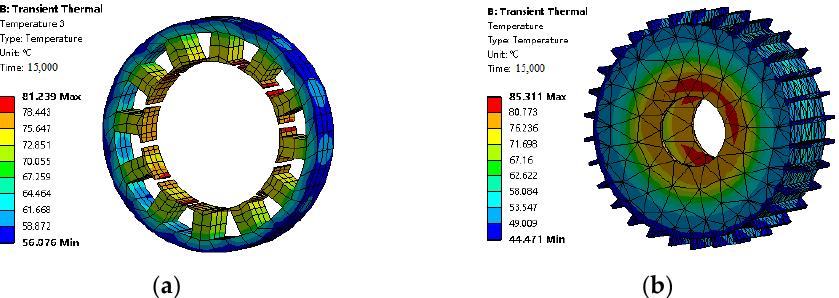
Figure 21. Temperature nephogram of DHEG when the ambient temperature is 25 °C, the excitation